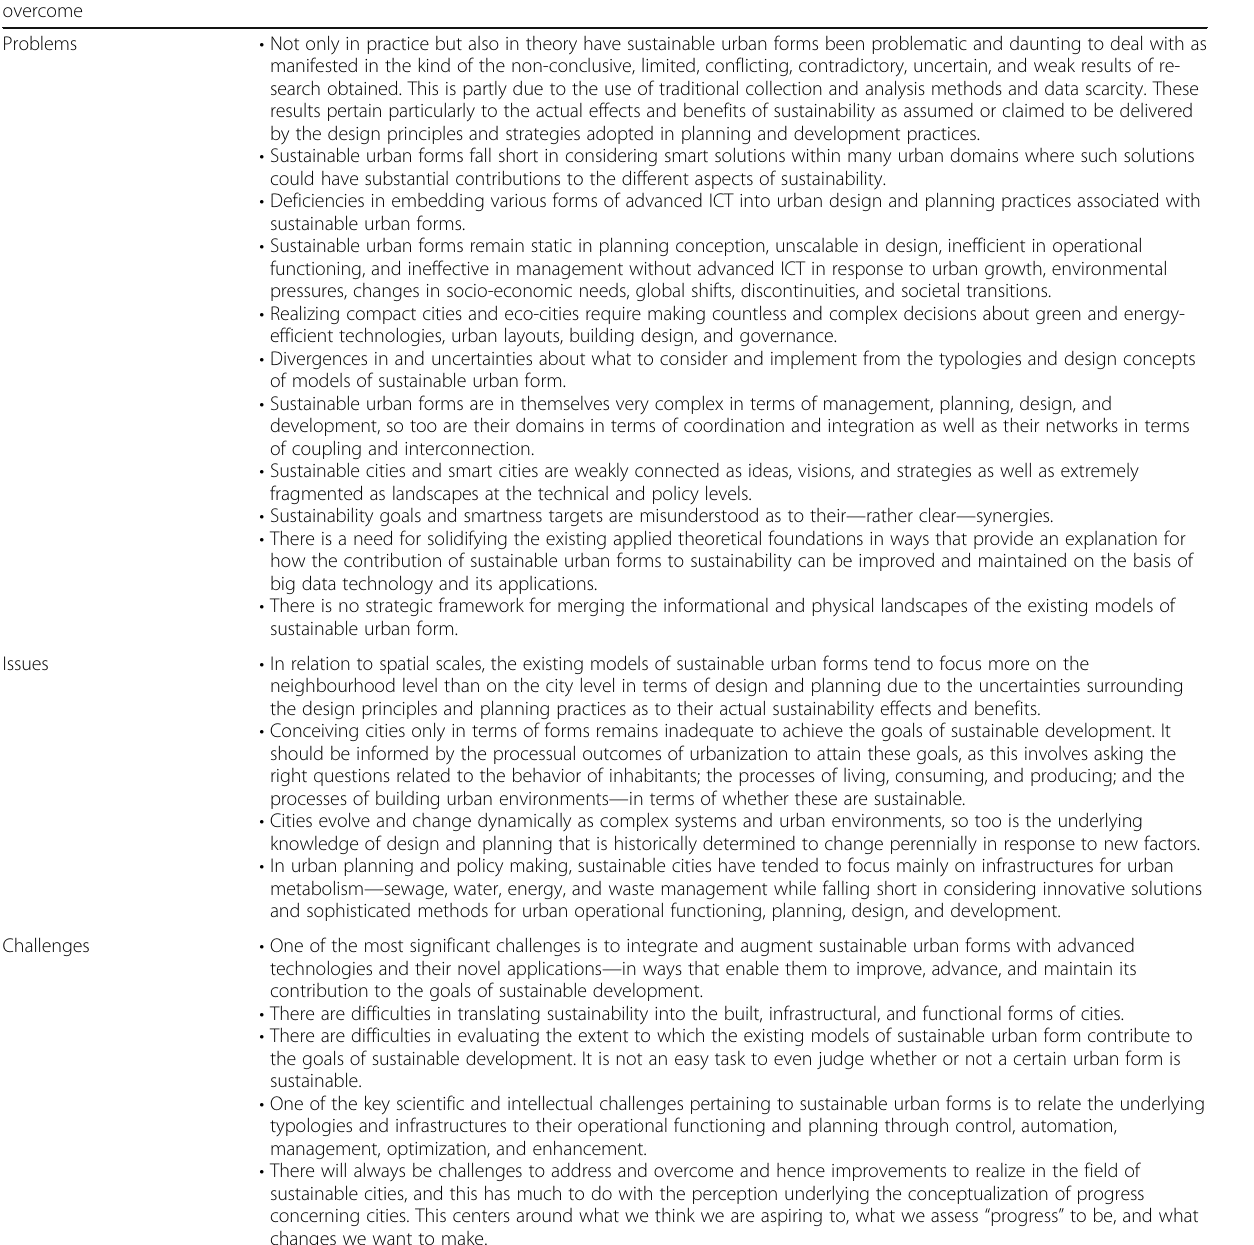
Table 3 Problems, issues, and challenges pertaining to sustainable urban forms What to solve, deal with, or overcome